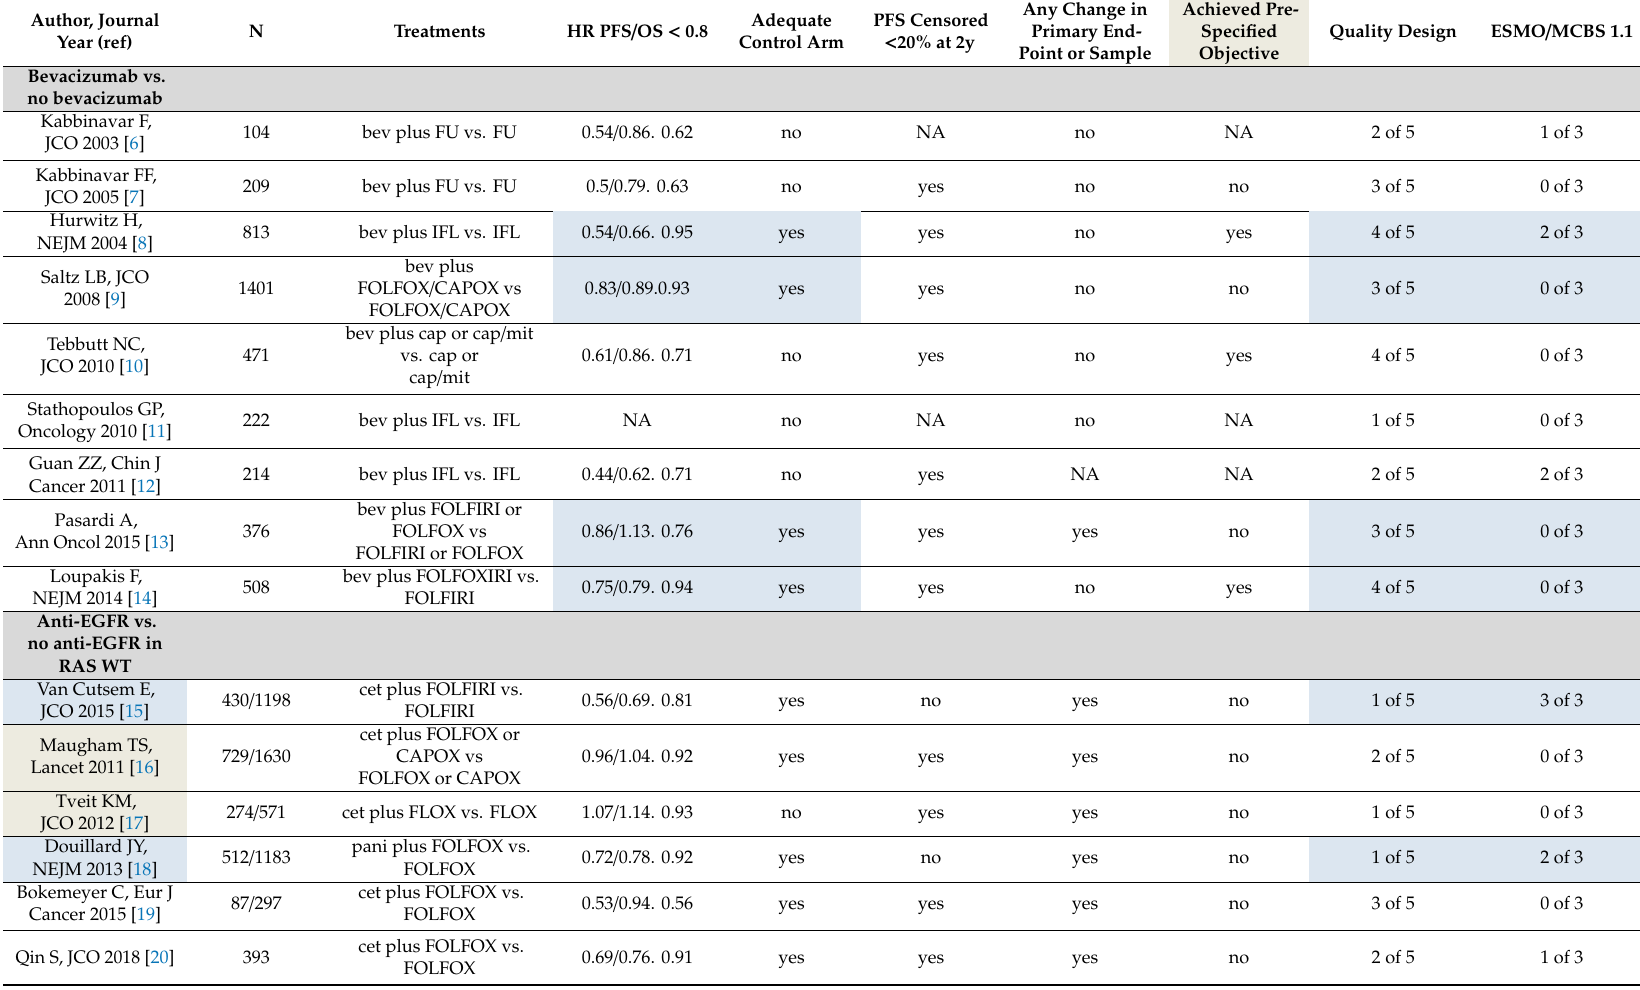
Table 1. Main randomized clinical trials in first-line treatment for patients with metastatic colorectal cancer